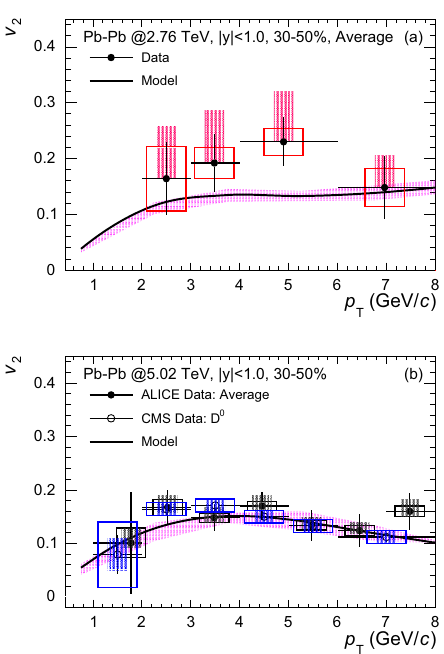
Fig. 9 Comparison between experimental data (red [57], black [58] and blue boxes [59]) and model calculations (solid black curve with pink uncertainty band) for the elliptic flow v 2 of non-strange D-meson at mid-rapidity ( | y | < 0 . 5) in semi-central (30–50%) Pb–Pb collisions √ √ s NN = 2 . 76 TeV ( a ) and s NN = 5 . 02 TeV ( b ). at